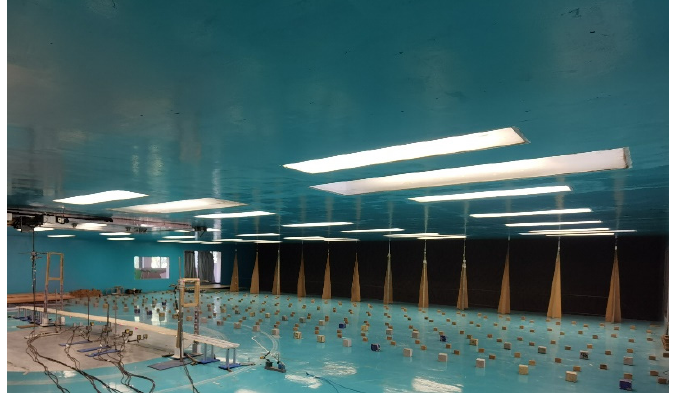
Figure 14. Atmospheric boundary layer turbulent wind field simulator.